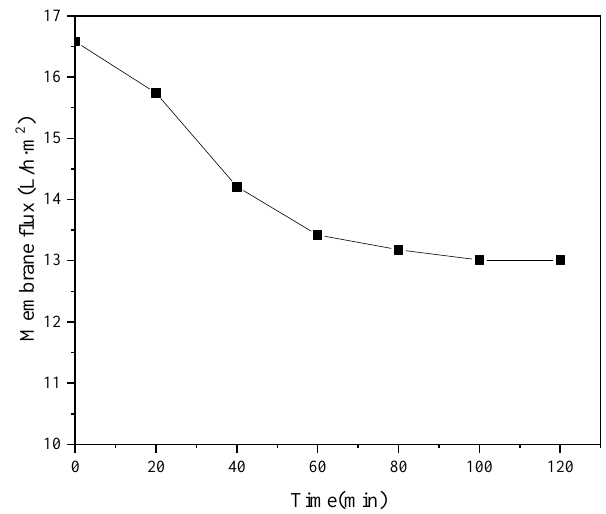
Figure 8. Effect of time on the freshwater membrane flux of NF.